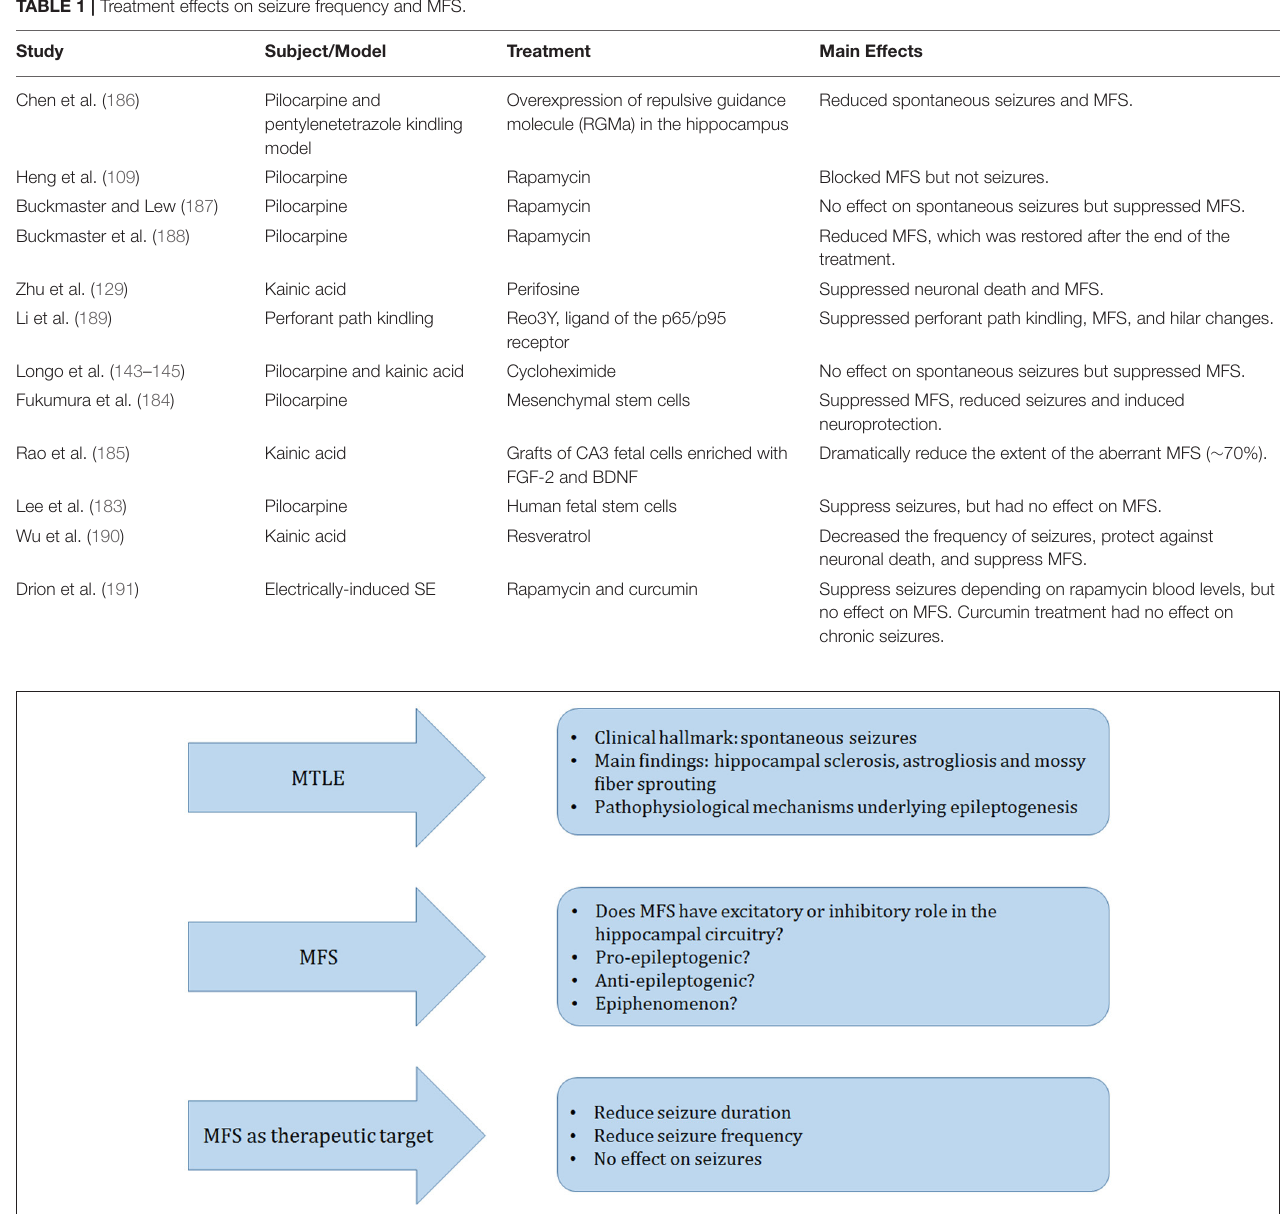
FIGURE 3 | Schematic representation of the main topics of this manuscript. Mesial temporal lobe epilepsy (MTLE) is clinically hallmarked by spontaneous seizures. The main pathological findings in the surgically resected hippocampus of patients and animal models of TLE are hippocampal sclerosis, astrogliosis, and mossy fiber sprouting (MFS), which are frequently studied to understand the mechanisms that may underlie epileptogenesis. We discussed three main different perspectives: Does MFS have a pro- or anti-epileptogenic role or is it an epiphenomenon? We finalize our review with a series of current alternative therapeutic approaches to reduce seizures and excitability that may affect or not the